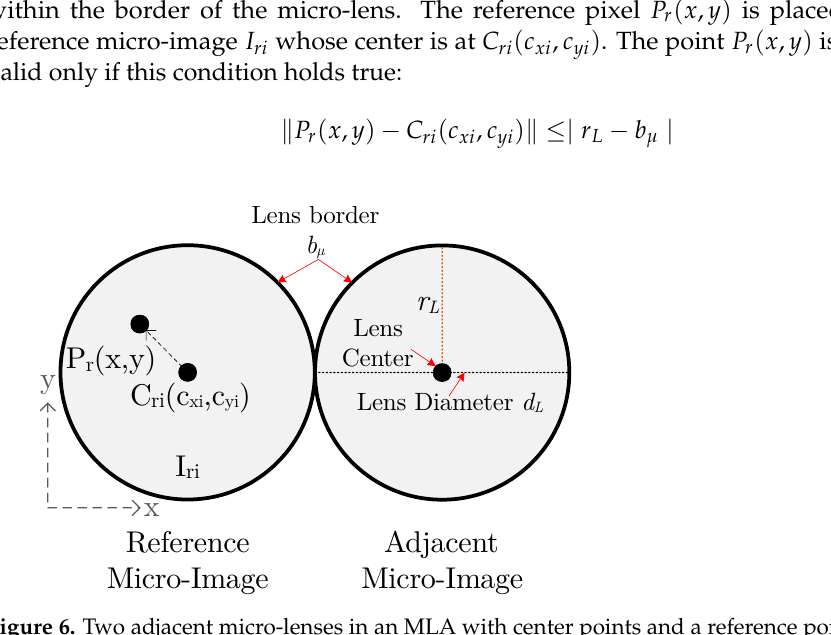
Figure 6. Two adjacent micro-lenses in an MLA with center points and a reference point P r ( x , y )